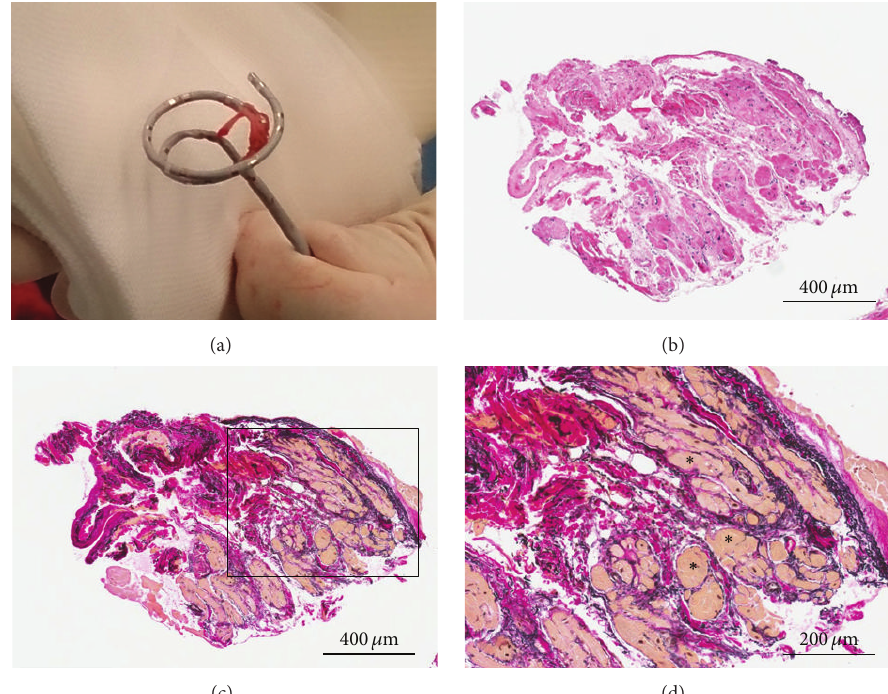
Figure 3: (a) The macroscopic image of removed multiloop mapping catheter. Fascicular connective tissue twined around the catheter tip. (b, c, d) The microscopic images of the removed tissue; (b) low-power field with Hematoxylin Eosin staining, (c) low-power field with Elastica van Gieson staining, and (d) high-power field of Elastica van Gieson staining. They consist of interstitial tissue including elastic fibers and patchy distribution of cardiomyocytes (∗) .